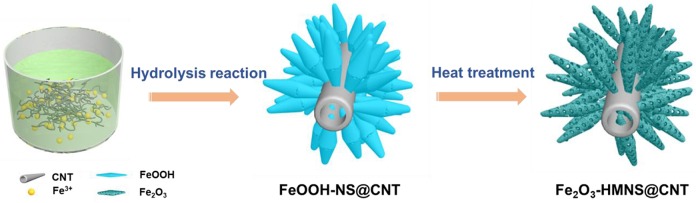
Schematic illustration of the preparation of the Fe2O3-HMNS@CNT composite.